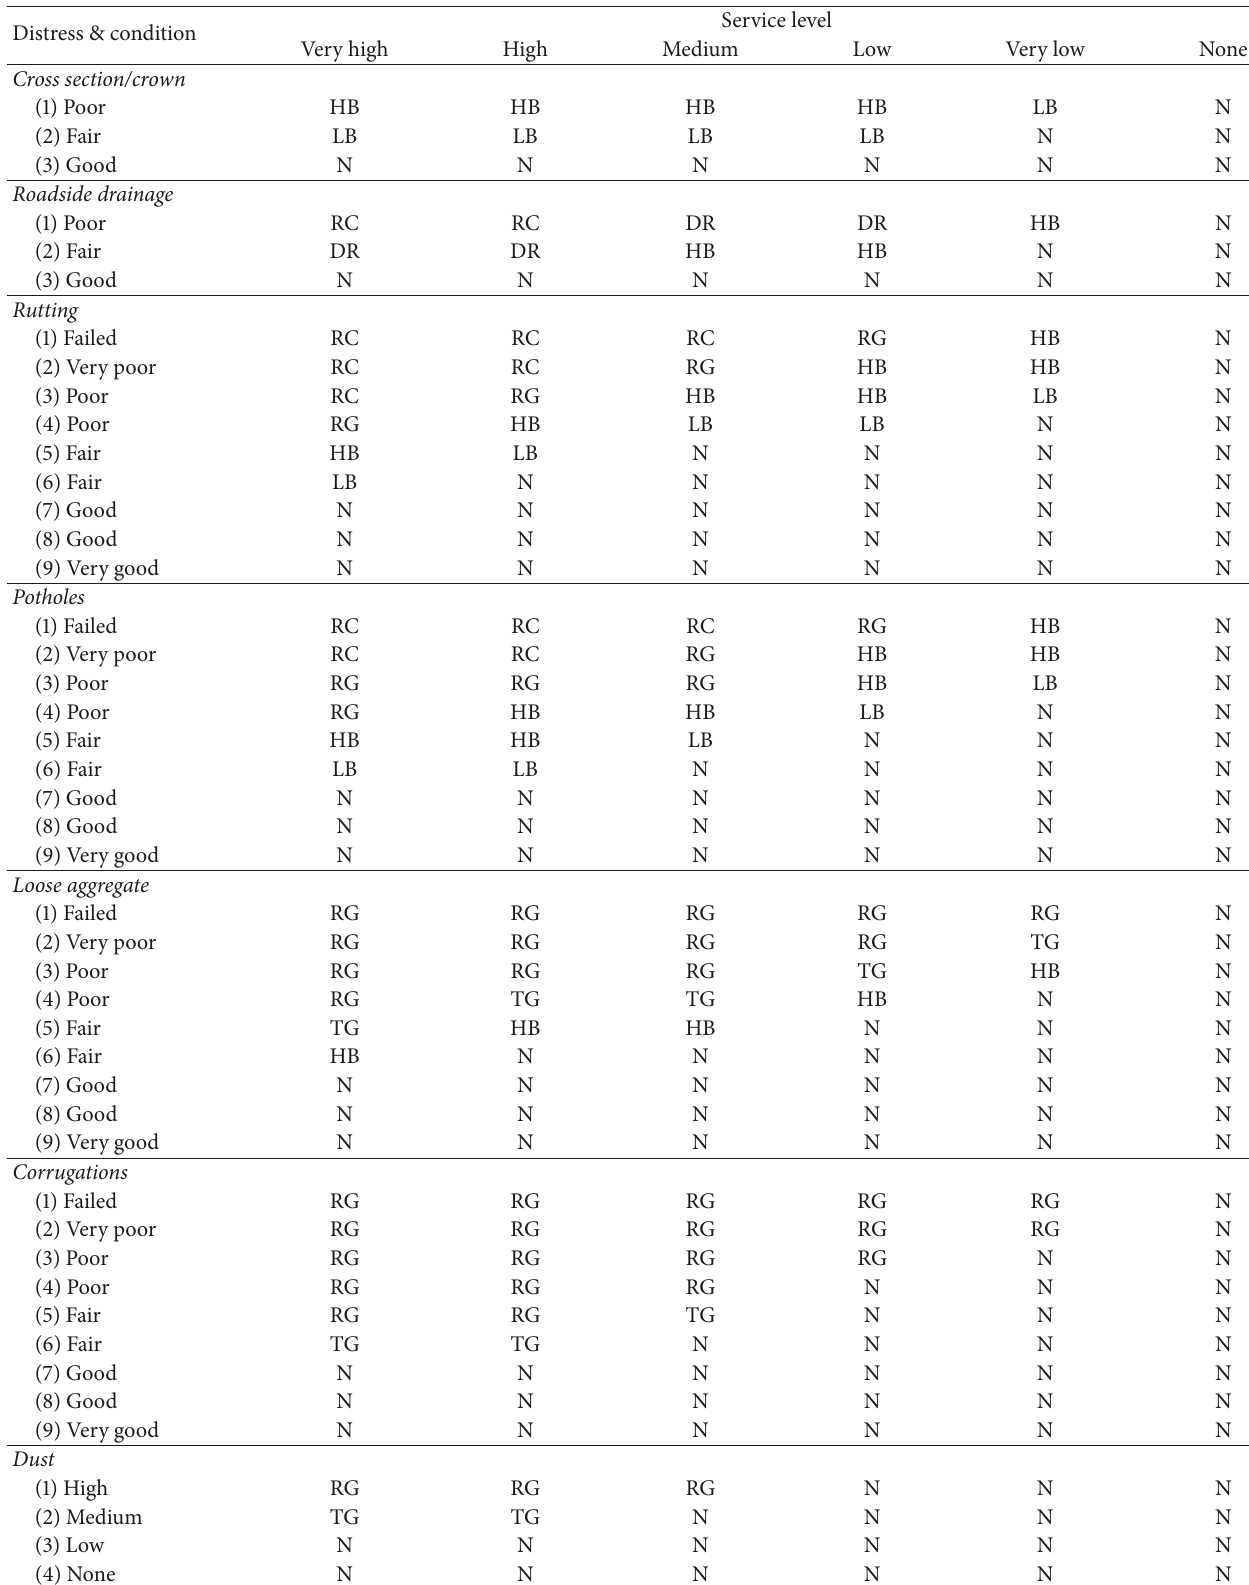
Table 2: County unpaved road treatment decision